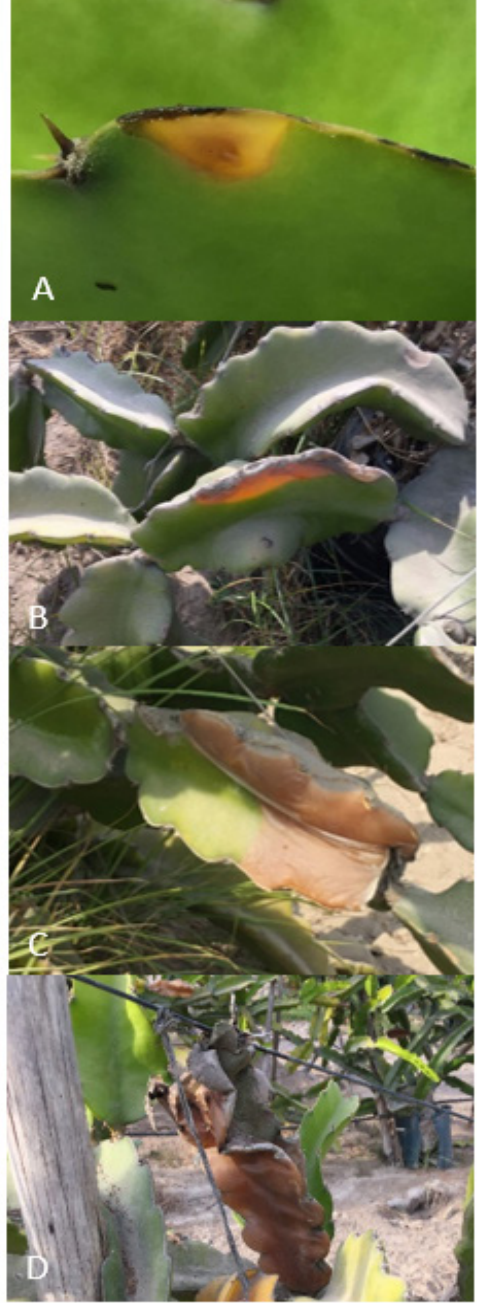
Figure 1. Symptoms at different stages of soft rot